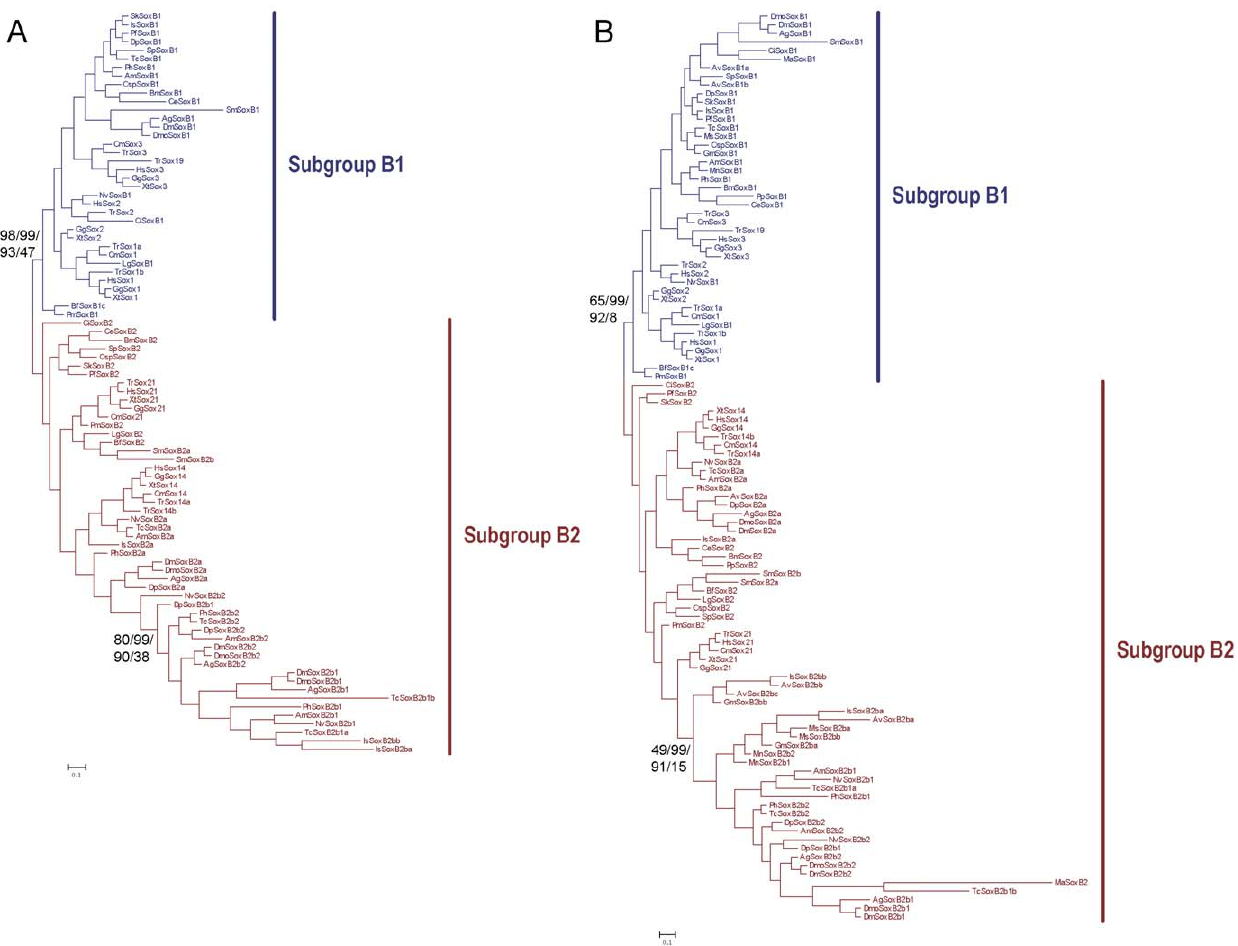
Figure 4. Phylogenetic trees of the bilaterian SoxB1/B2 proteins based on the HMG domain alignment. (A) Bayesian tree based on the alignment in Fig. 2 is shown. Statistical support values for the SoxB1/SoxB2 split and arthropod SoxB2b clade were derived with different methods, as described in Fig. 3. The model for the Bayesian reconstruction was JTT + I + G; the model for the ML reconstruction was LG + I + G. (B) Bayesian tree based on the alignments in Figs. 2 and S2B is shown. Order of statistical support values are as in (A). The model for the Bayesian reconstruction was RtREV + I + G; the model for the ML reconstruction was LG + I + G. Abbreviations of species names are as in Table 1.